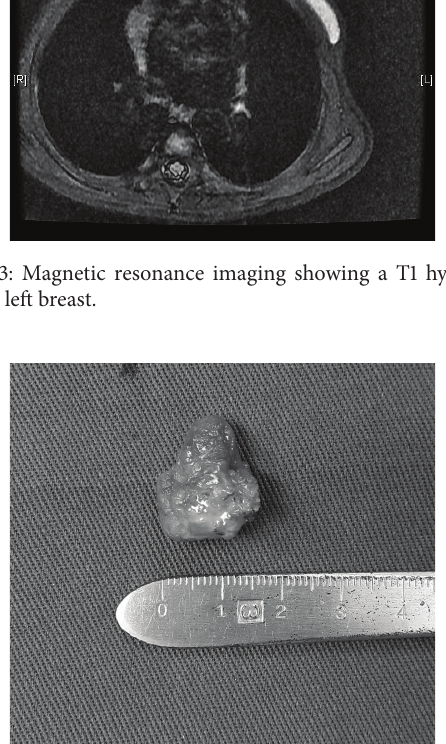
Figure 2: Ultrasonography of left breast showing a cystic lesion.